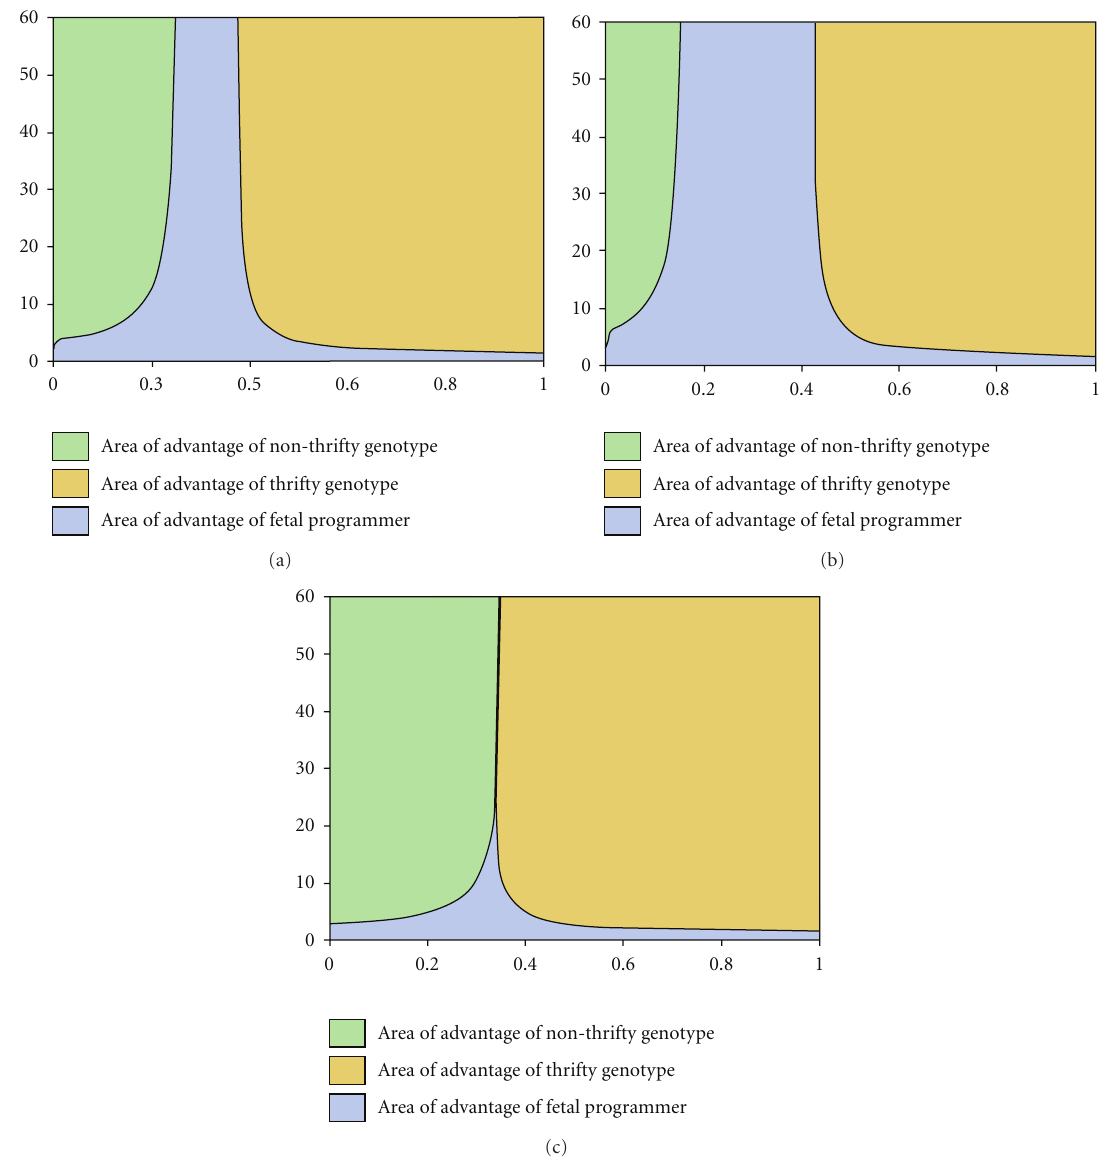
Figure 3: Parameter areas of advantage of the 3 genotypes when there is a correlation between birth-time and lifetime conditions: (a) r = 0 . 1, (b) r = 0 . 2, and (c) r = − 0 . 05. With a small positive correlation, the advantage of fetal programmer increases substantially. However, even very weak negative correlation can drive fetal programmer to extinction when life expectancy is high. Selection for fetal programming, therefore, must be driven by factors that produce significant positive birth-time and lifetime